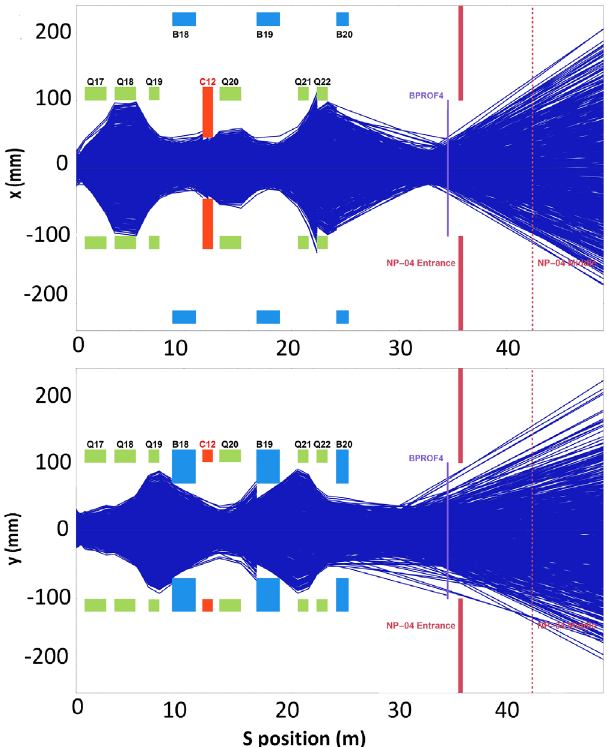
FIG. 5. Simulated mean losses of various misalignment types for H4-VLE. The misalignments studied had a Gaussian dis- tribution with a σ of 0.5 mm for spatial and 0.5° for angular misalignments. The transverse and angular misalignments of the quadrupoles affect the particle transmission the most.